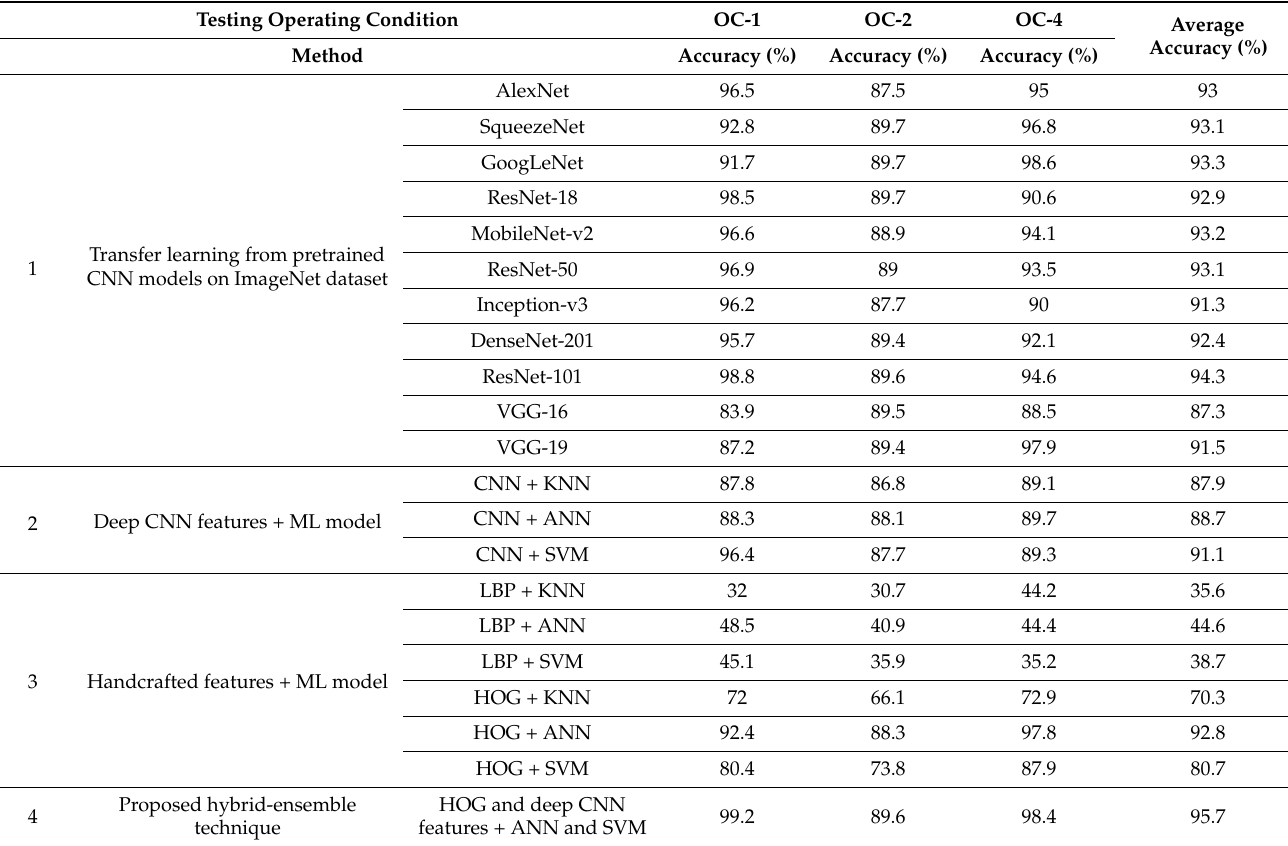
Table 5. Performance comparison results for different operating